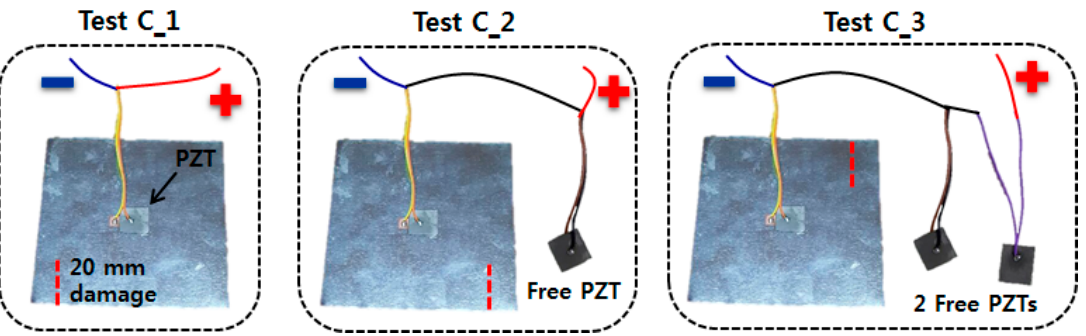
Figure 2. The setup for three test cases for evaluating the EMI performance subjected to amplitude